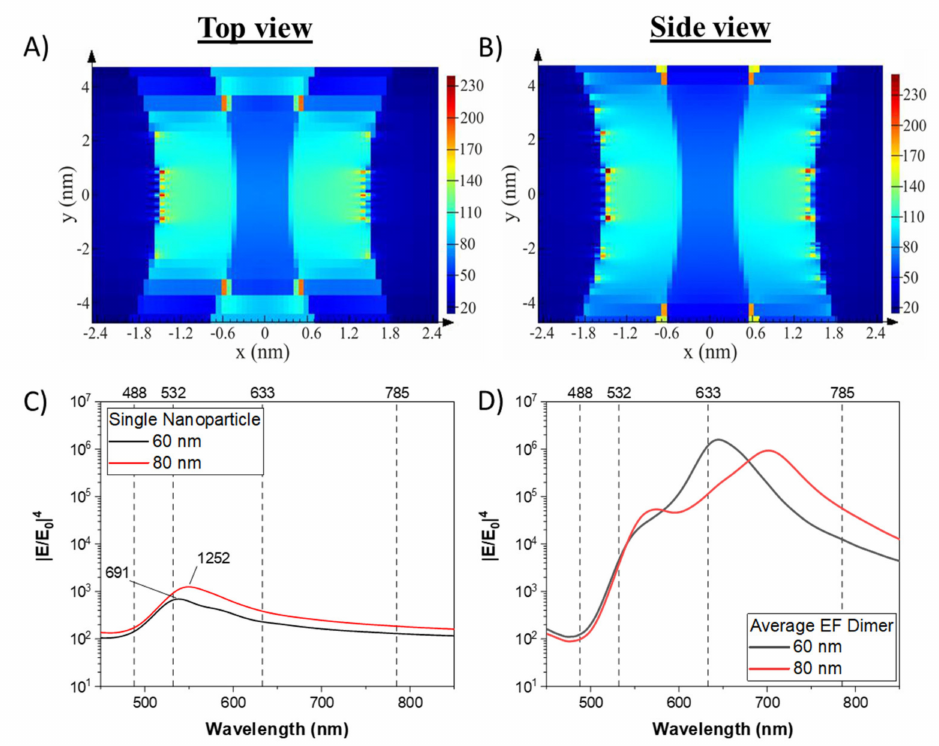
Figure 5. ( A , B ) FDTD simulated field enhancement map in the gap of a dimer composed of DNA coated 60 nm AuNP on a silicon substrate in both top and side view. The gap distance is constant at 3.5 nm between NP surfaces, and the excitation wavelength, in this case, is 633 nm and the polarization of the incident light is along the axis of the gap. The scale on the side indicates the |E/E 0 | intensity value. ( C ) FDTD simulation of the average enhancement factor ( EF , |E/E 0 | 4 ) of the 60 and 80 nm single AuNP in the function of the excitation light wavelength. ( D ) FDTD simulations of the average enhancement factor ( EF , |E/E 0 | 4 ) of the 60 and 80 nm AuNP dimers in function of the excitation